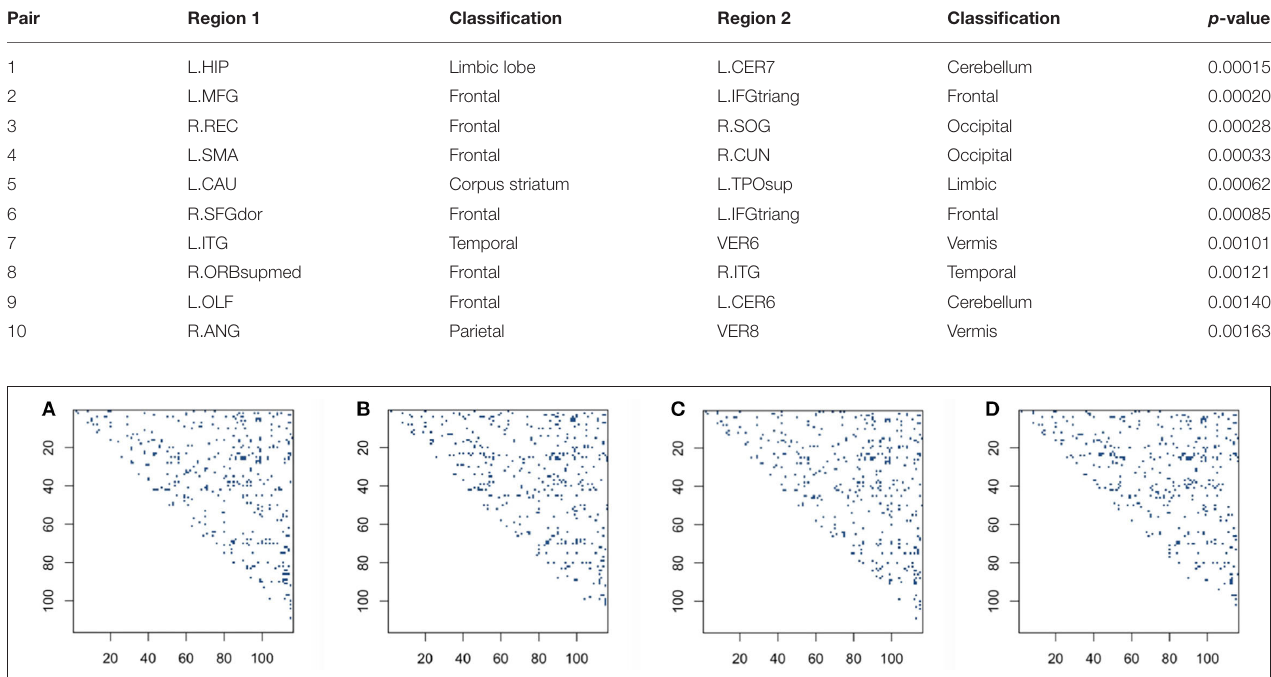
TABLE 3 | The first 10 most significant pairs for concentration inequality-based estimation method based on low-rank matrices. Pair